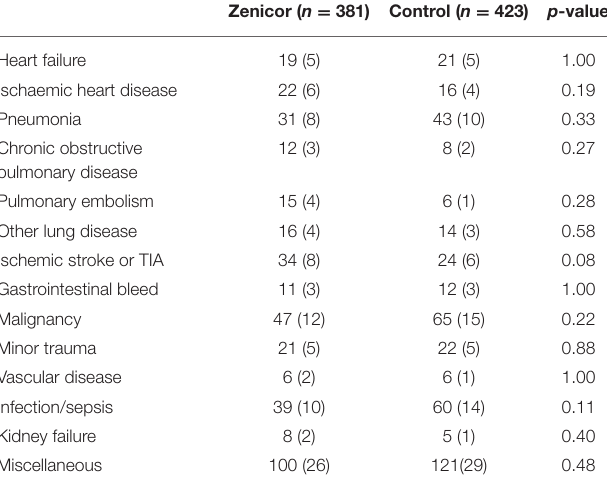
TABLE 2 | Main diagnosis during